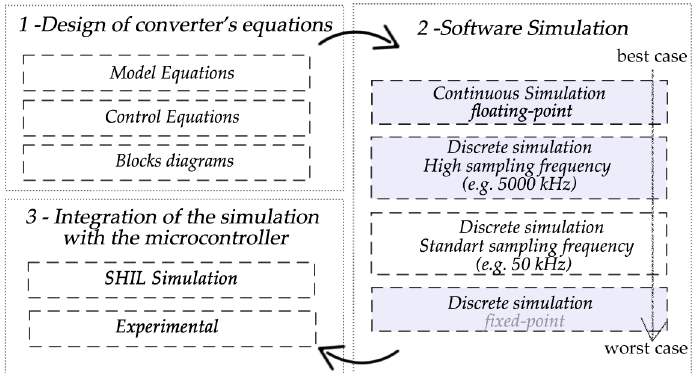
Figure 7. Methodology steps for SHIL simulation. The optional steps are highlighted in gray.